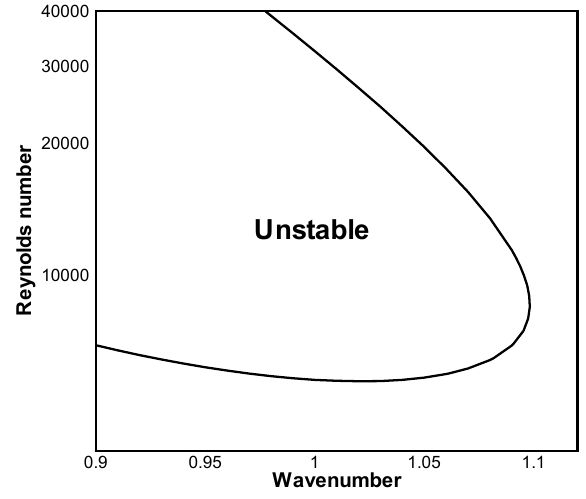
Figure A1. An example of neutral curve.